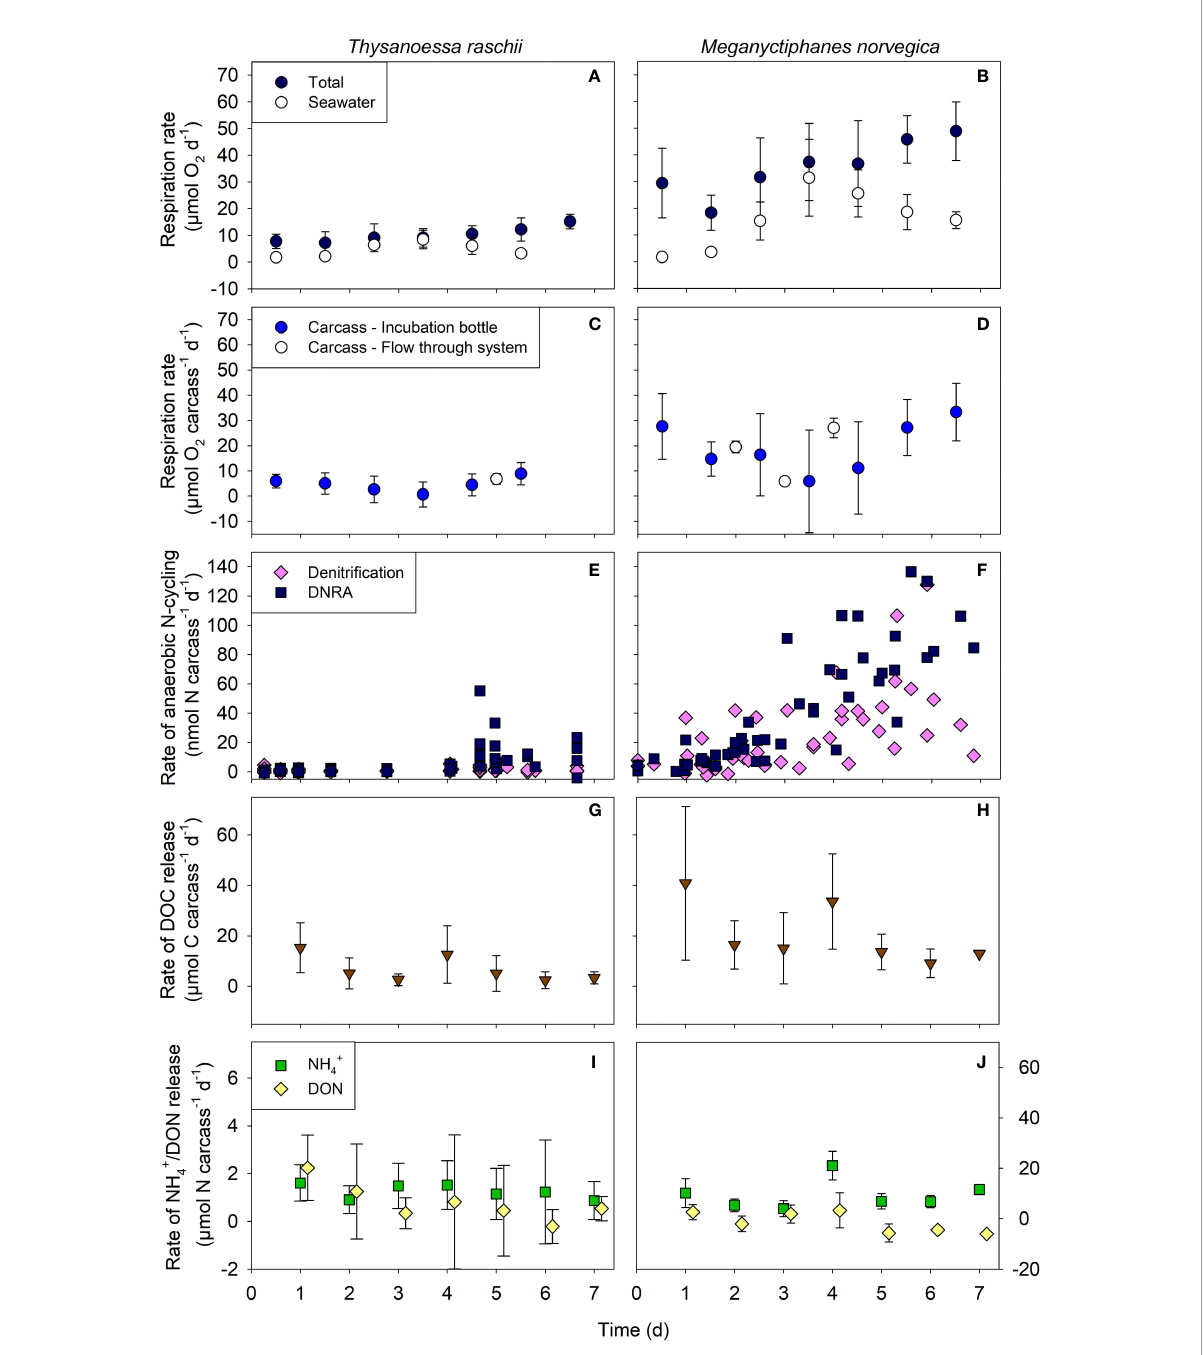
FIGURE 3 Rates of different aerobic and anaerobic processes measured in carcasses of Thysanoessa raschii (left panels) and Meganyctiphanes norvegica (right panels). (A, B) Total and seawater-associated microbial respiration rates. (C, D) Calculated carcass-associated microbial respiration in incubation bottles and the fl ow-through system. (E, F) Rates of denitri fi cation and dissimilatory nitrate reduction to ammonium (DNRA). (G, H) Rates of Dissolved Organic Carbon (DOC) release. (I, J) Rates of ammonium (NH 4+ ) and Dissolved Organic Nitrogen (DON) release. Mean and standard deviations of 6-7 replicates are